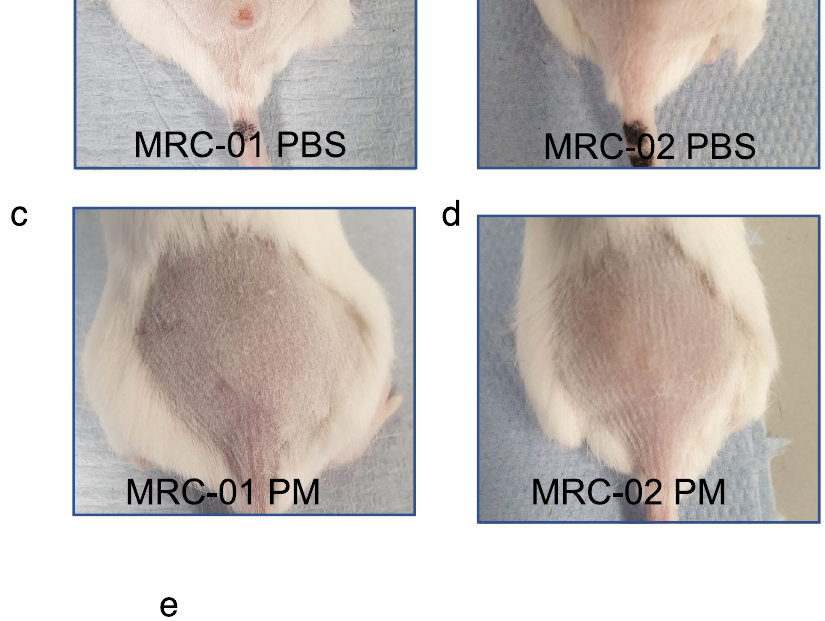
mice by sand fl y bite . Ten P. duboscqi females infected by L.